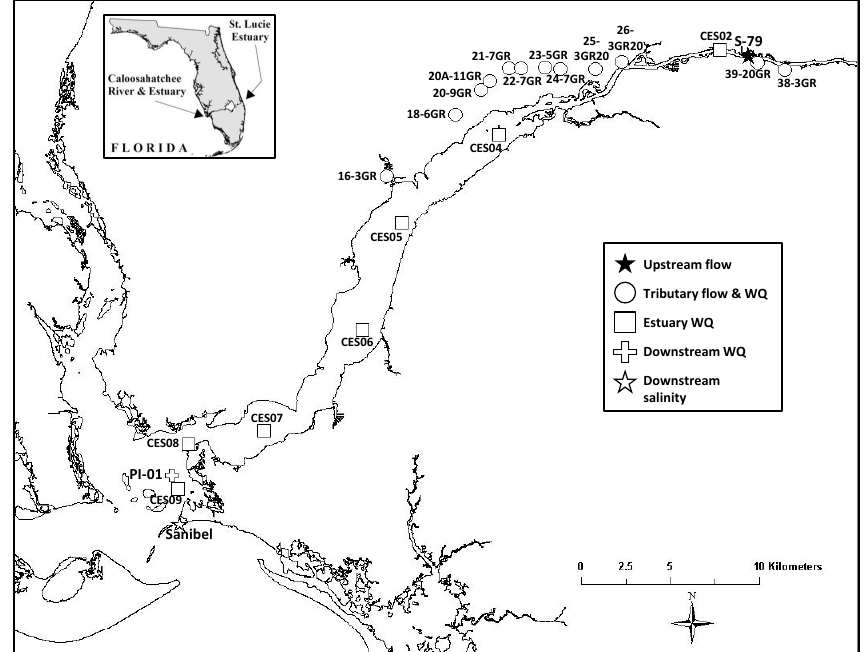
Fig. 1. Map depicting the Caloosahatchee River estuary. See Table 1 and Sect. 2.2 for details of data sources and integration into the nutrient budgets. Included is the upstream boundary site of gauged freshwater inflow (S-79; filled star), 12 locations of tributary water quality data (open circles), 7 locations of estuary water quality data (open squares), the location of downstream water quality data (PI-01; open cross), and the downstream boundary location for salinity (Sanibel; open